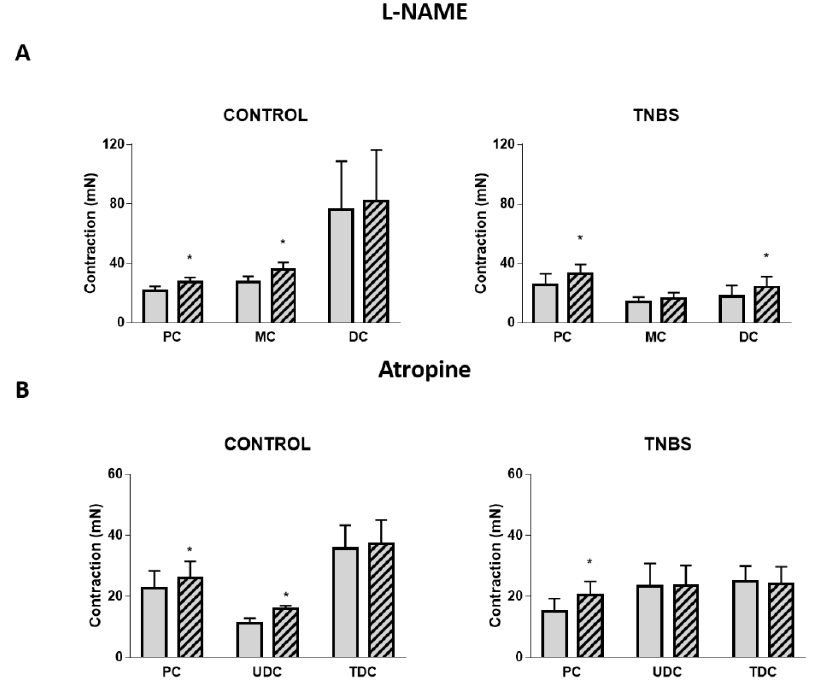
Figure 7. Contractile response to Ang II in the PC, MC and DC in the absence (gray bars) and presence (striped bars) of ( A ) L-NAME 100 µM in control (PC: n = 5; MC: n = 6; DC: n = 6) and TNBS-induced animals (PC: n = 6; MC: n = 5; DC: n = 6); and ( B ) atropine 1 µM in control (PC: n = 5; MC: n = 6; DC: n = 6) and TNBS-induced animals (PC: n = 6; MC: n = 5; DC: n = 5). * p < 0.05 vs. Ang II alone.